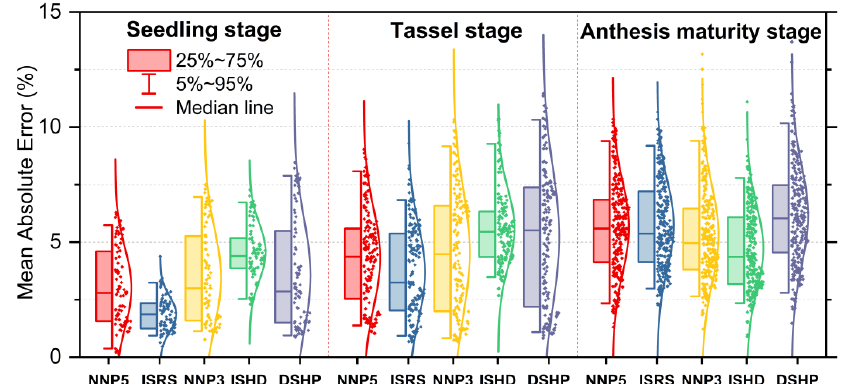
Figure 10. Characteristics of the model simulation errors at different growth stages.